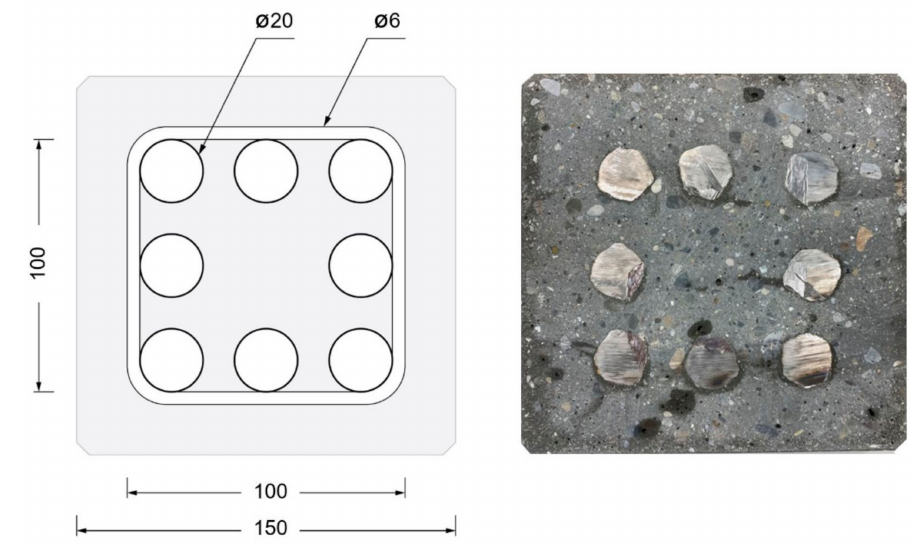
Figure 10. ( Left ): cross-section of a standard formwork with reinforcement. ( Right ): section cut of DCS result in standard formwork using Industry Mix with digital casting. The stirrups are not shown in the picture as the slice made did not cut through one of